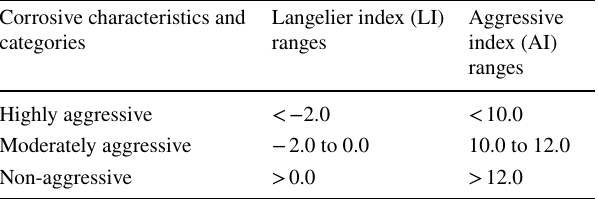
Table 6 Classification of water according to corrosive characteristics